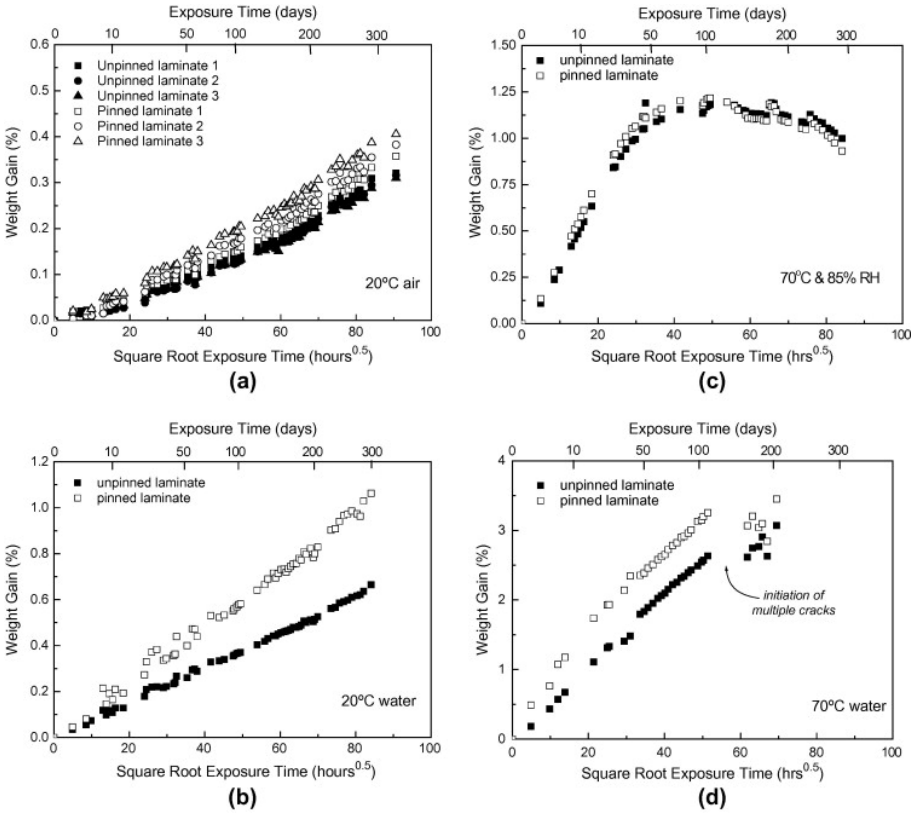
Figure 33. Percentage weight gain-exposure time curves for the unpinned and pinned laminates. The exposure conditions were ( a ) 20 ◦ C in air, ( b ) 20 ◦ C in water, ( c ) 70 ◦ C and 85% relative humidity (hot / wet) and ( d ) 70 ◦ C in water. Three curves for both materials are presented in ( a ) to show the typical scatter in the weight gain values between samples. The curves in ( b )–( d ) are the average weight gain curves based on three samples [37].